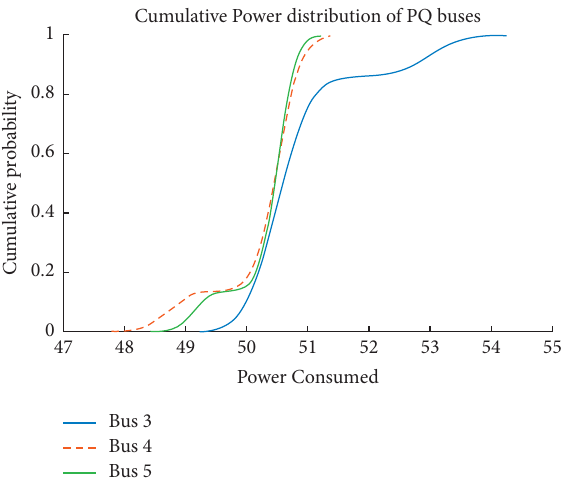
Figure 9: Power density distribution at buses 3–5.